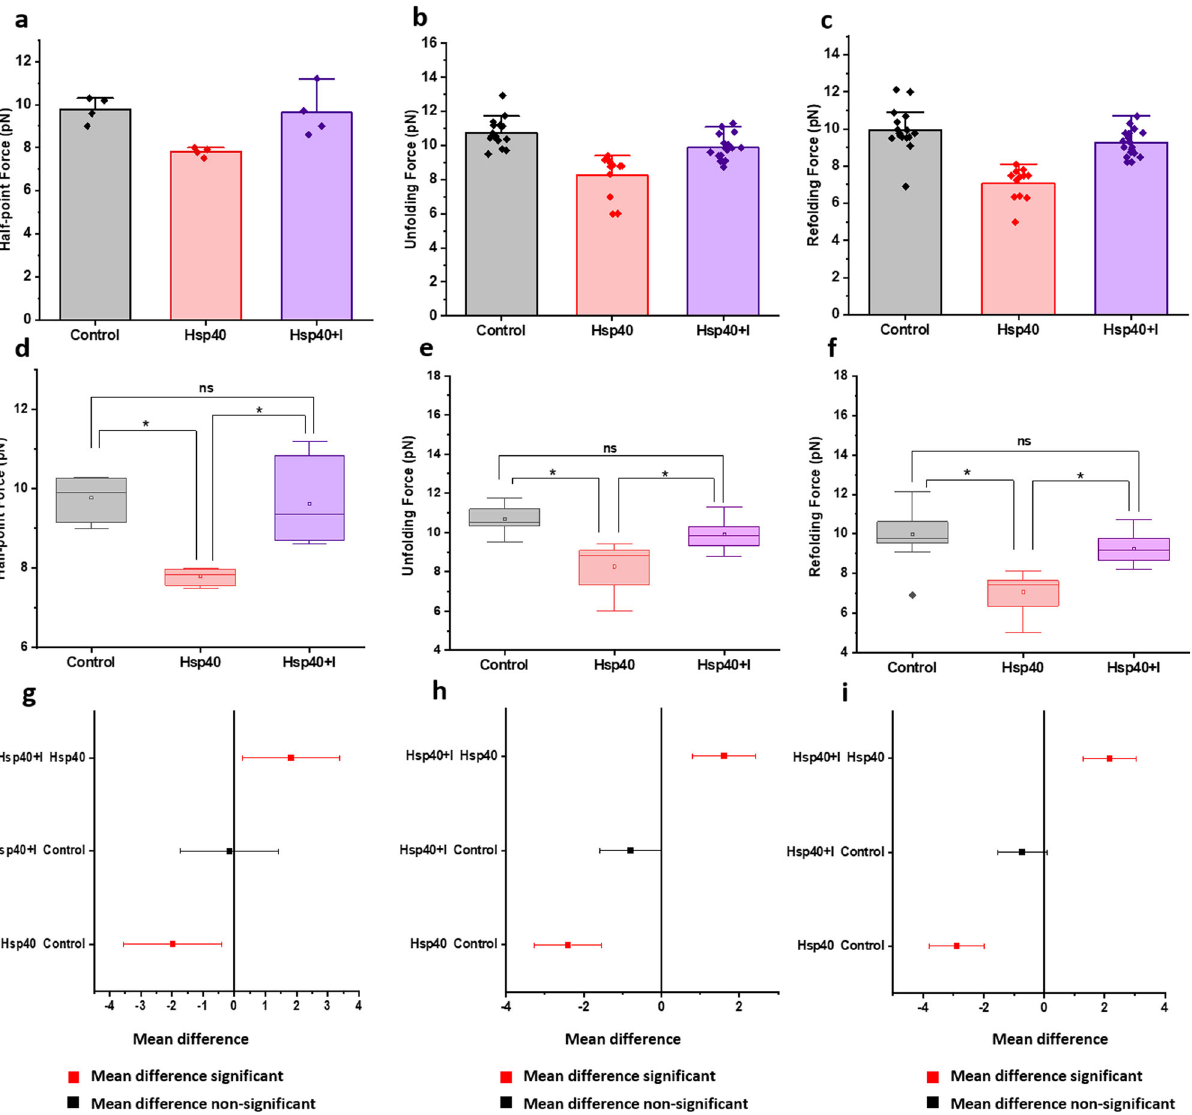
Fig. 8 Talin mechanics with Hsp40 inhibition by KNK437. Inhibition of Hsp40 chaperone promote innate talin mechanics by restoring a half-point force, b unfolding force, and c refolding force. ANOVA analysis has been performed for each of the d , g half-point force; e , h unfolding force; f , i refolding force. To cross-check the statistical signi fi cance of different force data sets, we performed one-way ANOVA analysis and observed that the force data with Hsp40 both in the presence and absence of its inhibitor are statistically signi fi cant, which is also evident from a mean comparison of their data sets. Since the inhibitor reverts the Hsp40 activity and thereby, talin exhibits innate mechanical stability as comparable to control data, mean force differences are statistically non-signi fi cant between the Hsp40 inhibitor complex and control. ( R 2 = 0.652 for half-point force; 0.553 for unfolding force; and 0.608 for refolding force). For the half-point force analysis, n = 4 molecules are measured and averaged for each data sets. For force analysis, unfolding forces are measured and averaged; n = 15 (control), n = 12 (Hsp40), n = 18 (Hsp40 + inhibitor). For refolding force, n = 16 (control), n = 12 (Hsp40), n = 18 (Hsp40 +